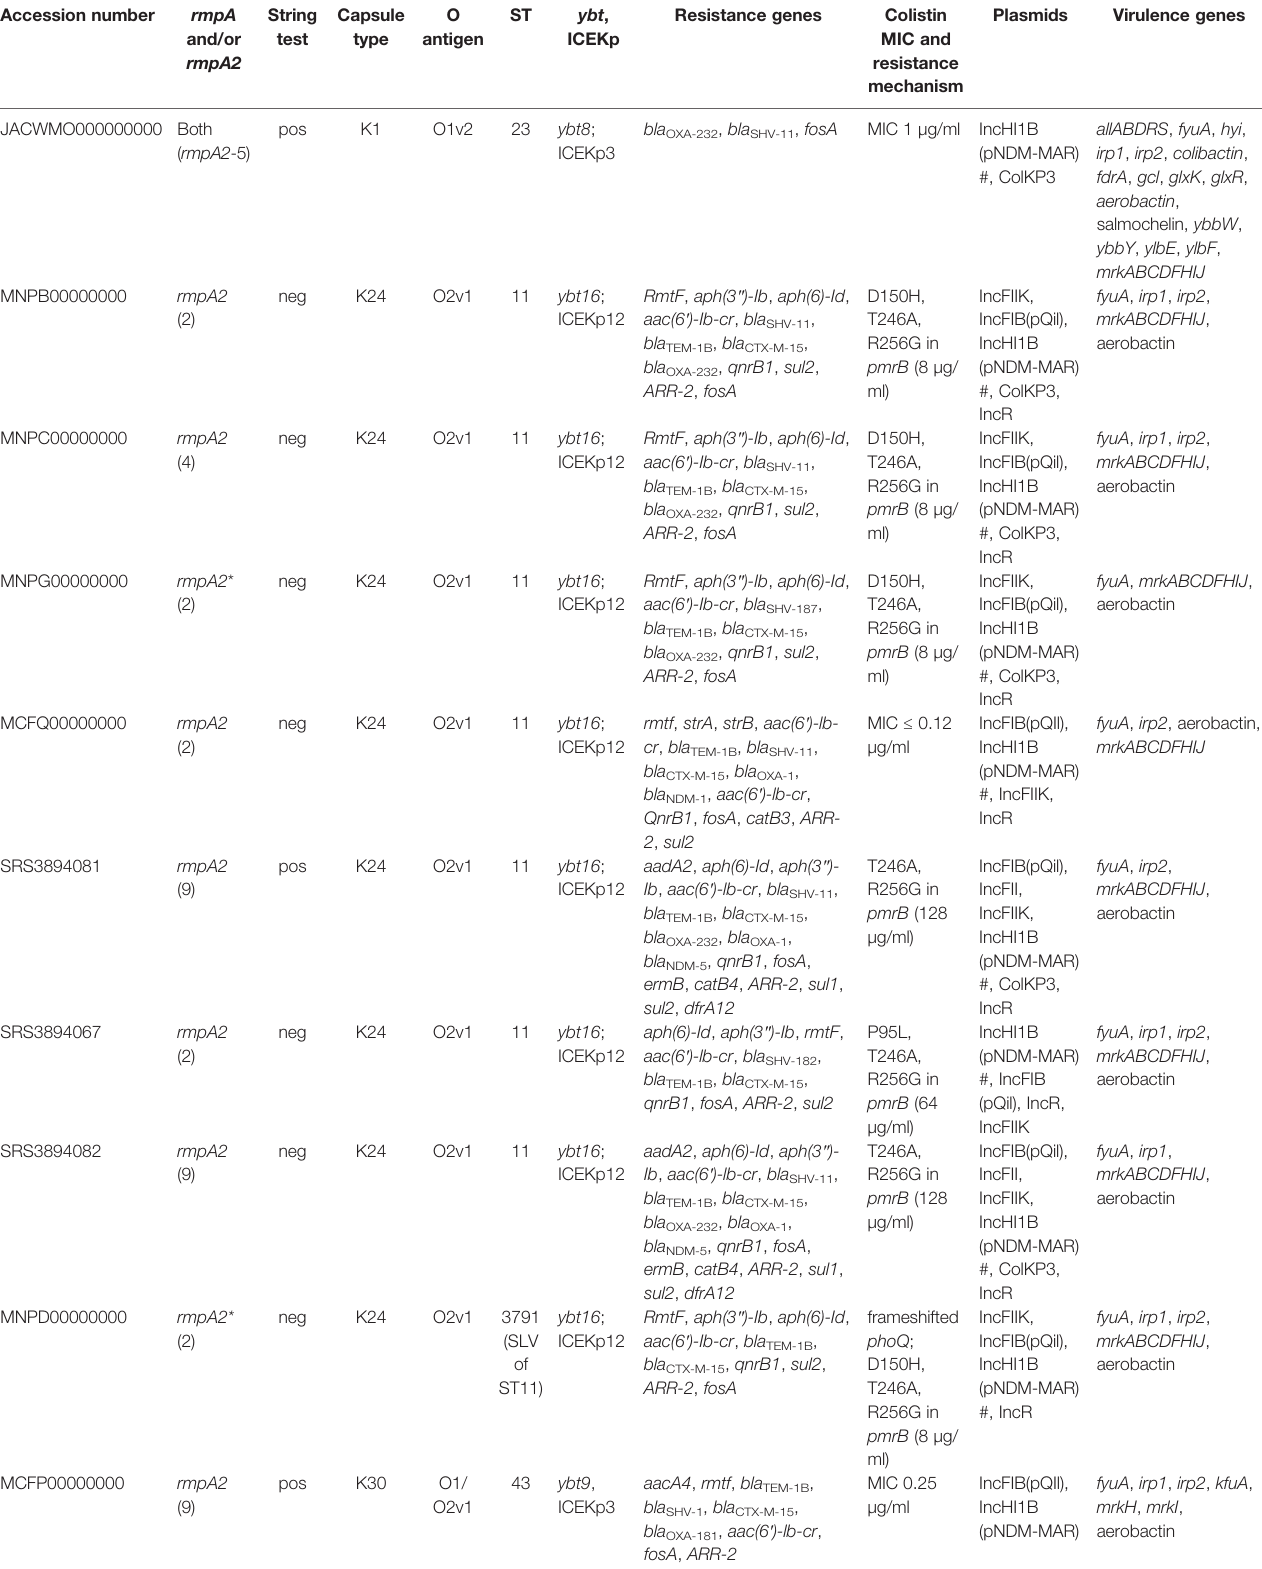
TABLE 1 | Results of the whole-genome analysis showing characteristics of carbapenem resistant hypervirulent